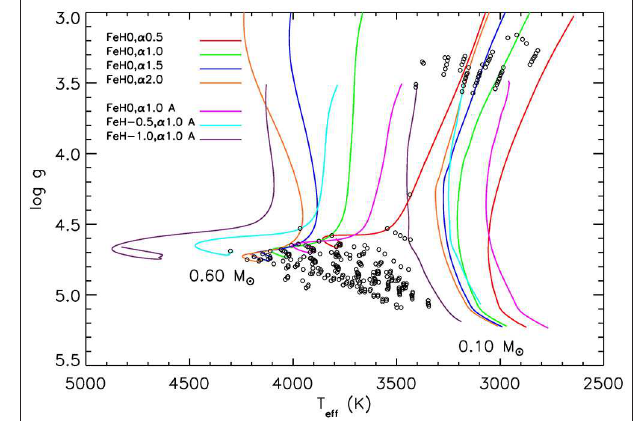
FIGURE 1 | Evolutionary tracks of the 0.10 and 0.60M ⊙ models of the different grids in RL14. Labels refer to FeH0 = solar metallicity; FeH-0.5 and FeH-1 subsolar metallicity, α = mixing length parameter, A = model with atmosphere. Open circles plot the location of the unstable models and define the instability strip in terms of T eff and log g . Figure from